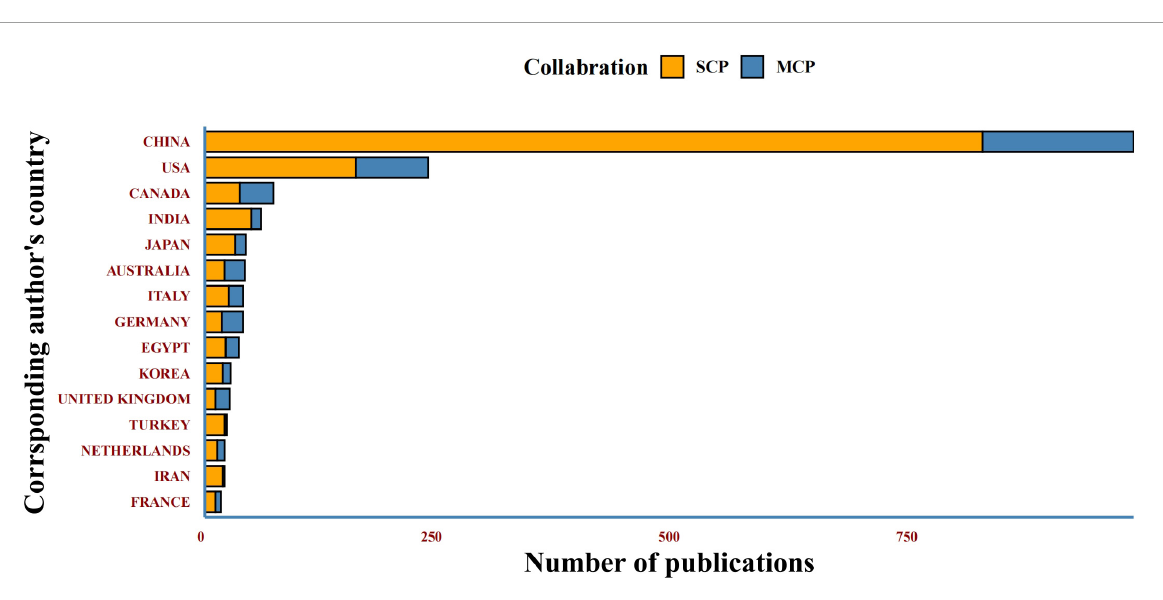
FIGURE6 Top 20 corresponding author’s countries. SCP-Single Country Publications; MCP- Multiple Country